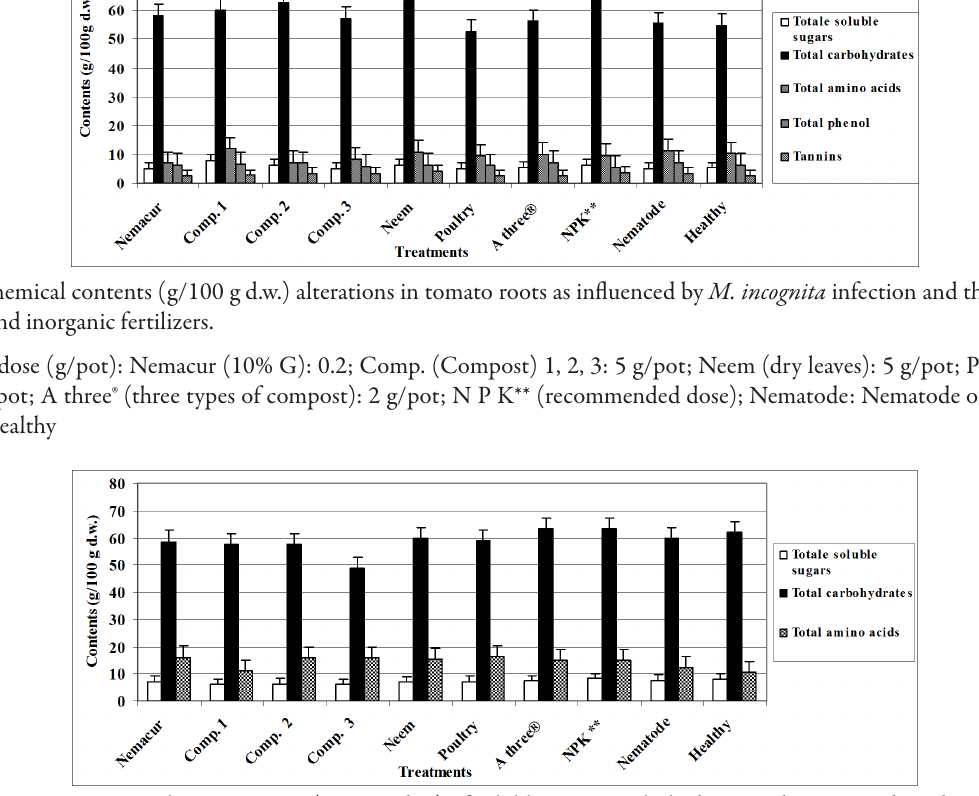
Fig. 2. Alterations in tomato shoots contents (g/100 g d.w.) of soluble sugars, carbohydrates and amino acids as directed by M. in- cognita infection and the application of organic and inorganic fertilizers. Treatments dose (g/pot): Nemacur (10%G): 0.2; Comp. (Compost) 1, 2, 3: 5 g/pot; Neem (dry leaves): 5 g/pot; Poultry